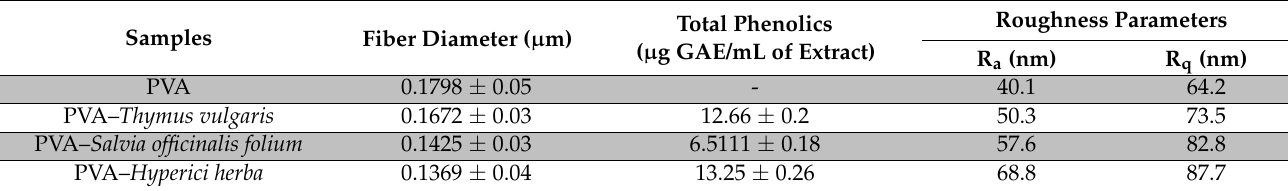
Table 1. The values of the average fiber diameter, total phenolics, and R a and R q parameters of the PVA and PVA loaded with phytotherapeutic